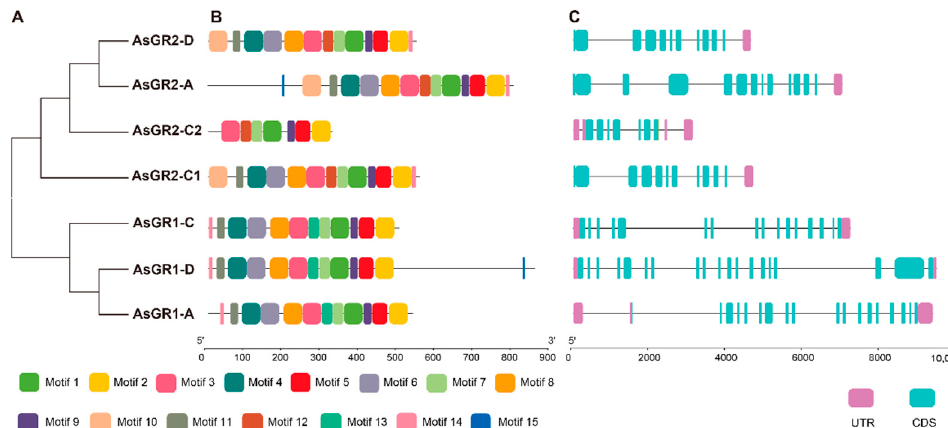
Figure 3. The motif pattern and gene structure of GR members in A. sativa . ( A ) Phylogenetic clustering showed that AsGR members were grouped into two subfamilies. ( B ) The schematics represents the motif patterns of AsGR proteins. Different colored boxes indicated the fifteen different MEME-motifs. ( C ) Gene structures of the seven AsGR genes. Pink boxes indicate untranslated regions (UTR), and exons and introns are indicated by turquoise boxes and black lines, respectively.